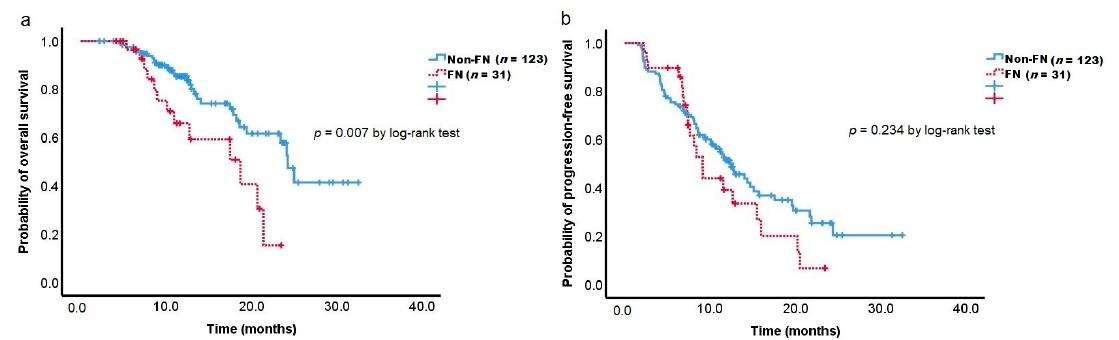
Figure 1. Kaplan–Meier estimates of overall survival ( a ) and progression-free survival ( b ) according to febrile